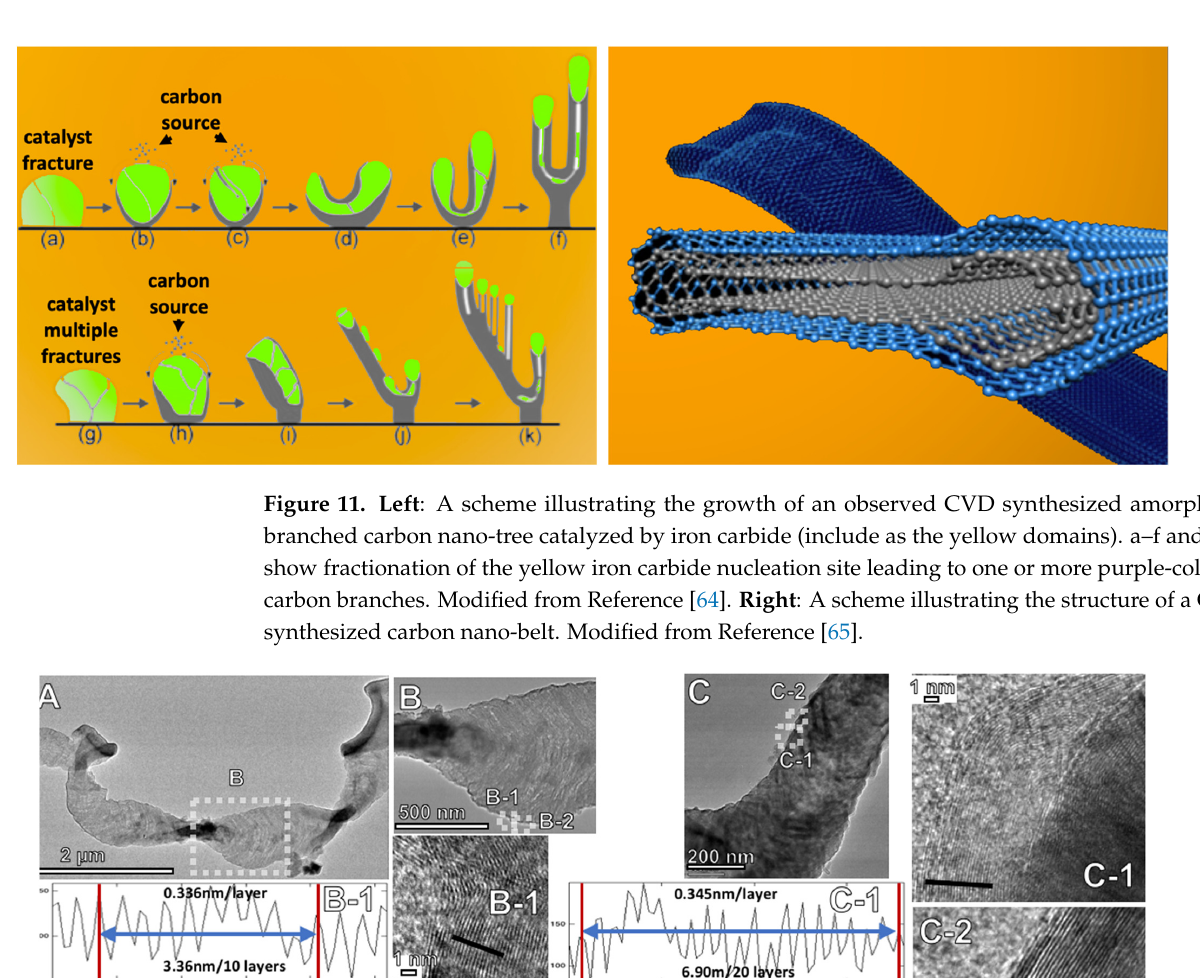
Figure 10. TEM and TEM HAADF elemental analysis of the nano-trees carbon allotrope synthesized by molten carbonate electrolysis. ( A , B ), B-2, B-3, ( C ), C-1, C-1-1, ( D ), D-1, ( E ), E-1, E-2-1, ( F ), F-1, ( G ), G-1. G-2, TEM of Nano-trees; B-1, B-4, D-1-1, E1, G1-1, G1-2, G2-1; TEM of Nano-trees with meas- ured graphene layer thickness; ( H , I ) HAADF of Nano-tree with elemental profile (right side).